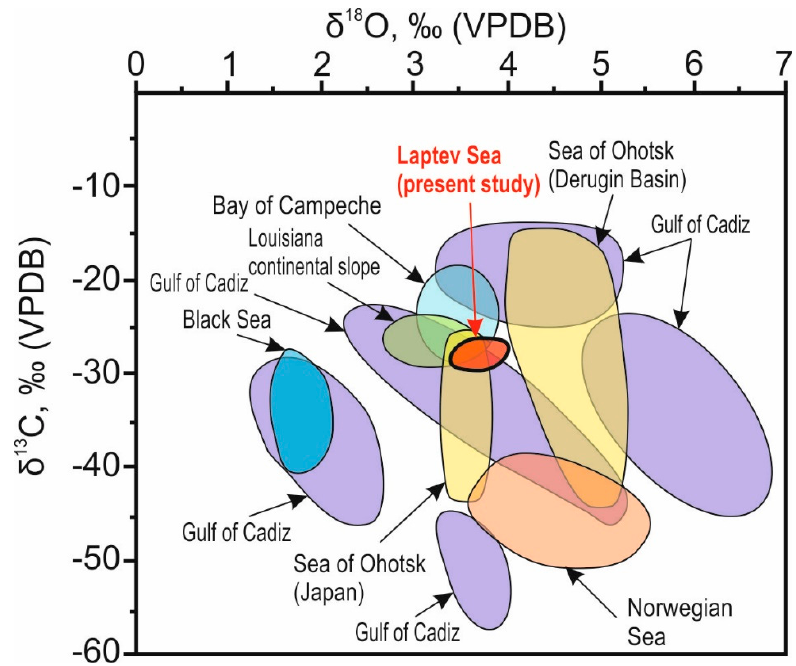
Figure 6. Carbon and oxygen isotopic compositions for authigenic carbonates from the Laptev Sea in comparison with other authigenic carbonates from different areas. Isotopic data for carbonates from Sea of Ohotsk, Norwegian Sea, Black Sea, Louisiana continental slope, Bay of Campeche modified from [26] and references therein, and for carbonate chimney samples from the Gulf of Cadiz modified from [42,43].